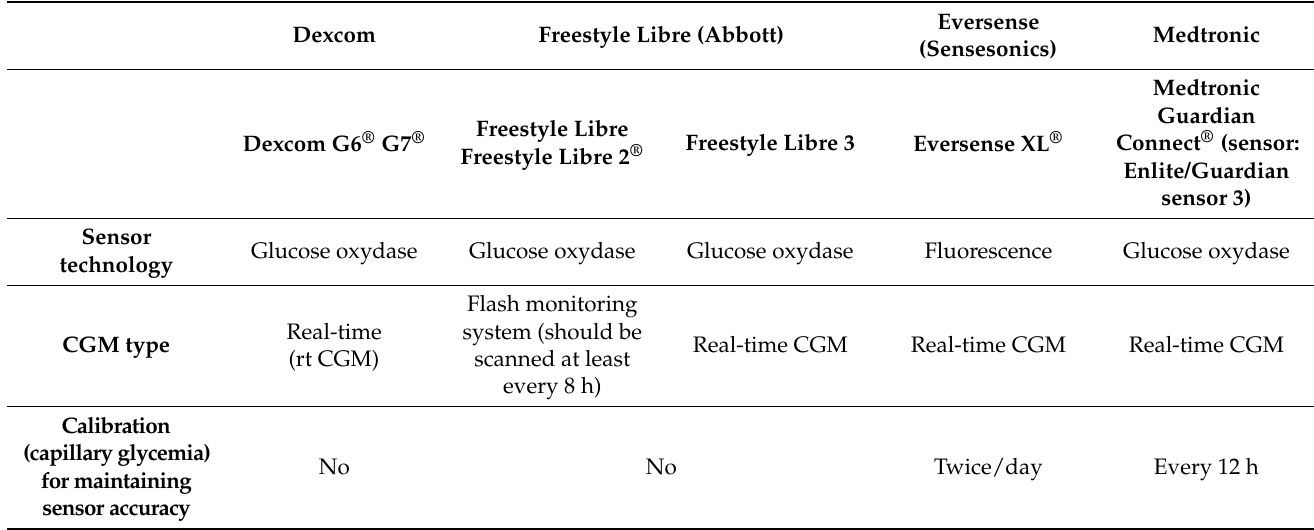
Table 1. Key characteristics of the most frequently used personal CGM